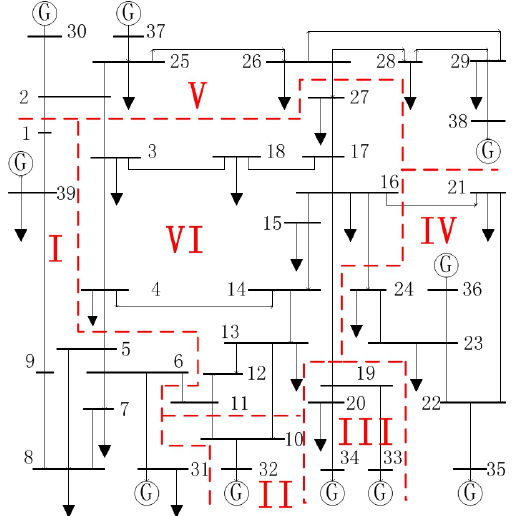
Figure 6. Structure diagram of IEEE 39-bus test system. The split regions marked by red dashed lines will be later discussed in Section 3.